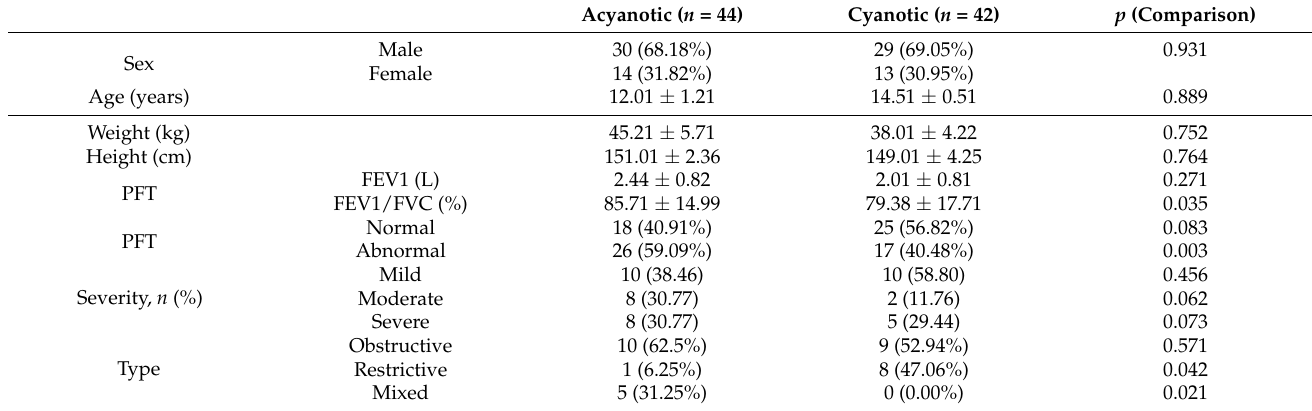
Table 2. Comparison of spirometry data between the two types of CHD in our patients (acyanotic vs. cyanotic).